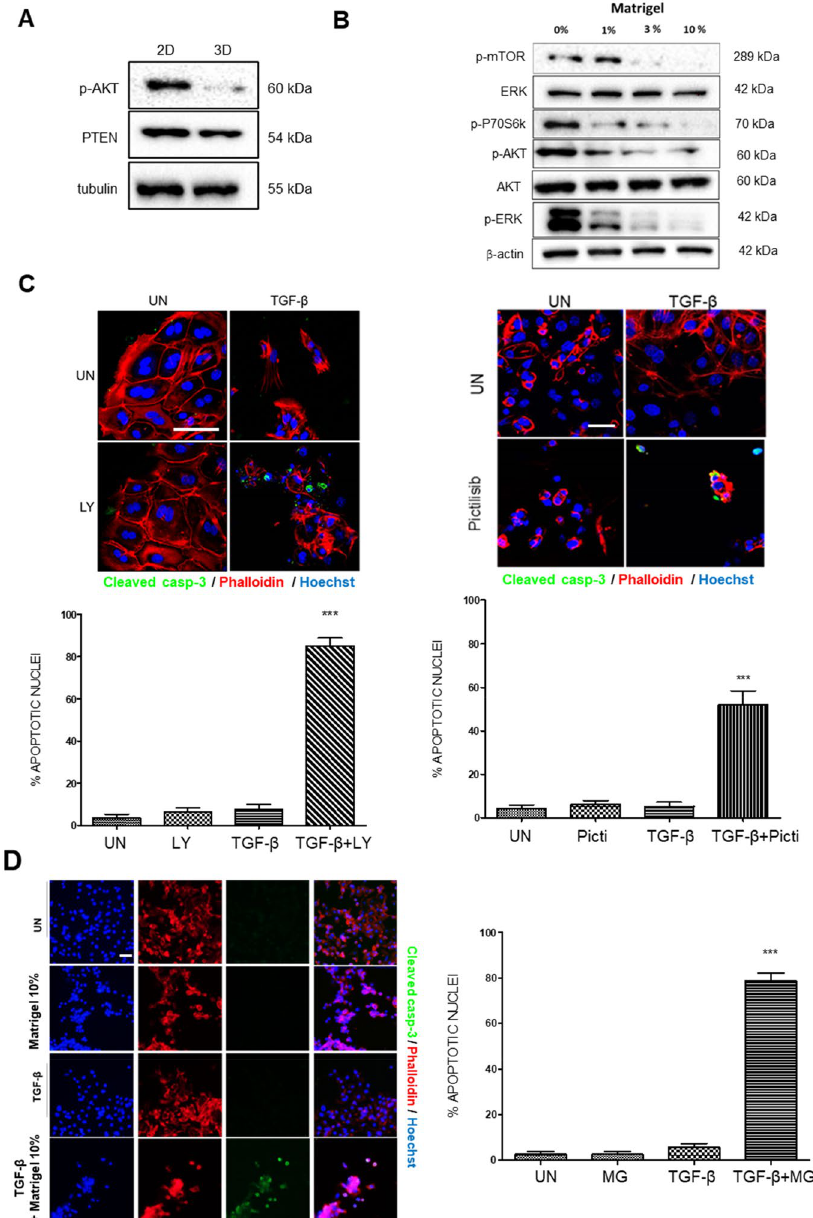
Figure 2. ( A ) Western blot analysis of phosphorylated AKT (p-AKT) and PTEN on lysates obtained from 2D monolayer or 3D organoid cultures. Membrane was re-blotted with tubulin to check for equal protein loading. ( B ) Western blot analysis of phosphorylated mTOR (p-mTOR), phosphorylated AKT (p-AKT), phosphorylated p70S6K, phosphorylated ERK, and PTEN on lysates obtained from 2D monolayer stimulated for 48 h with the indicated percentage of Matrigel diluted in basal culture medium. Membrane was re-blotted with β-actin, total ERK and total AKT to check for equal protein loading. ( C ) Representative confocal images and quantification of cleaved-caspase-3 immunofluorescence corresponding to 2D monolayer cultures with PI3K inhibitors. 20 µM LY294002 (LY) (left) or 200 nM Pictilisib (Picti) (Right). The cultures were treated with 20 ng/ml TGF-β alone, 20 µM LY, 200 nM Picti, combination of 20 ng/ml TGF-β plus 20 µM LY (TGF-β + LY) or 20 ng/ml TGF-β plus 200 nM Picti for 48 h. UN, untreated. Cells were counterstained with phalloidin to visualize actin cytoskeleton and morphology, and Hoechst to visualize nuclei. Scale bars: 25 µm. Values are mean and error bars represent mean ± S.E.M. *** P < 0.001 by one-way ANOVA, followed by the Tukey’s multiple comparison test. ( D ) Representative confocal images and quantification of cleaved-caspase-3 immunofluorescence corresponding to 2D monolayer cultures treated with TGF-β, 10% Matrigel, 10%Matrigel plus TGF-β or left untreated (UN). Cells were counterstained with phalloidin to visualize actin cytoskeleton and morphology, and Hoechst to visualize nuclei. Scale bars: 25 µm. Values are mean and error bars represent mean ± S.E.M. *** P < 0.001 by one-way ANOVA, followed by the Tukey’s multiple comparison